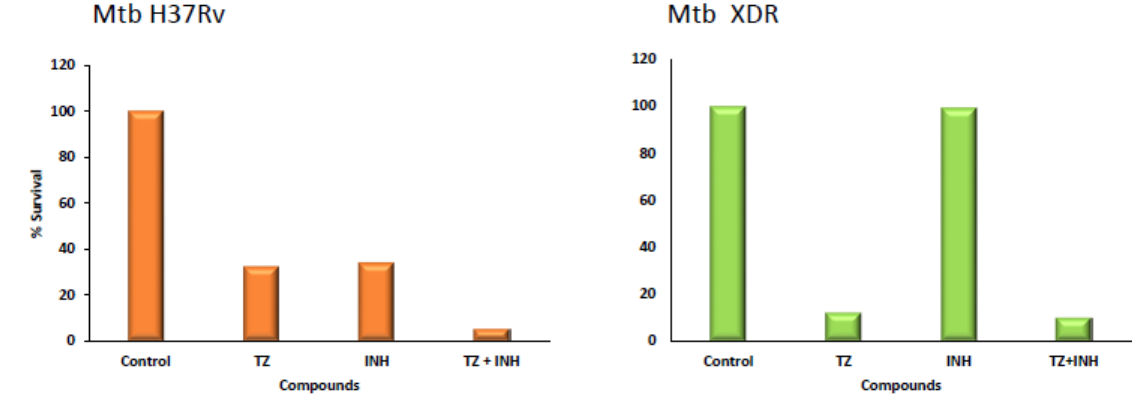
Figure 2. Killing effect of thioridazine over three days of infection. Effect of thioridazine on the intracellular survival of M. tuberculosis (Mtb) H37Rv and an XDR Mtb strain within human monocyte-derived macrophages at day three post infection. Isoniazid (INH) was tested at 0.1 μ g/mL, and thioridazine (TZ) at 2.5 μ g/mL. Data are presented as a mean of the percentage of the survival (adapted from [26]).